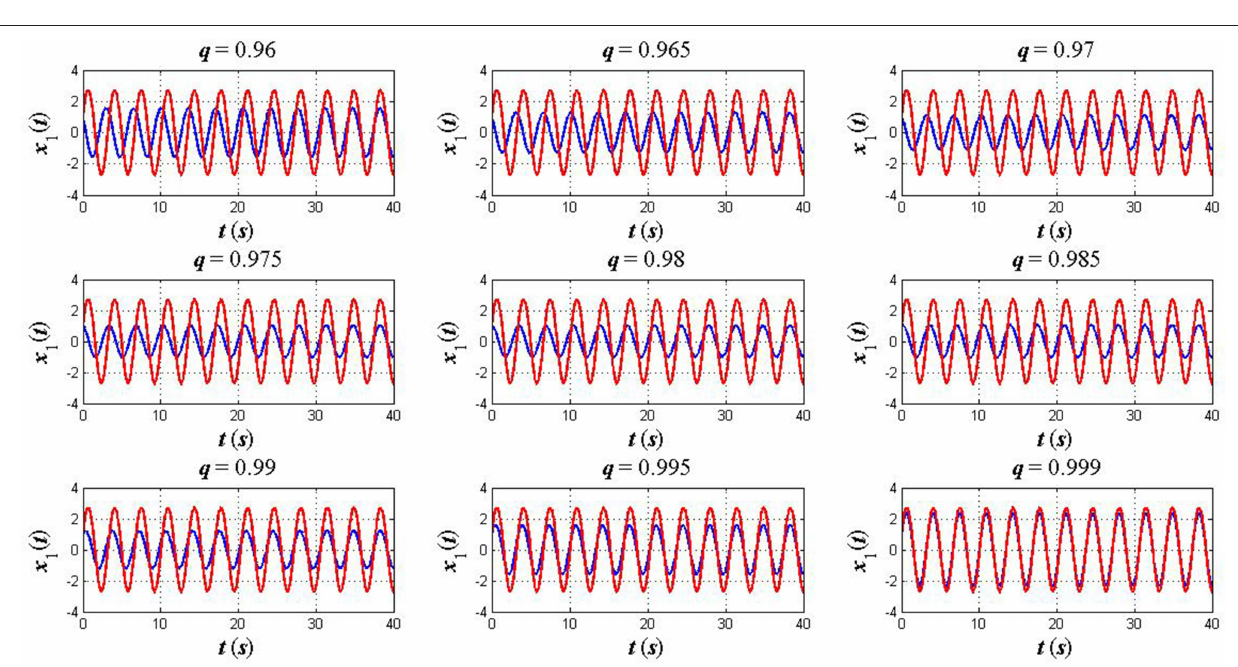
Frontiers in Physics |